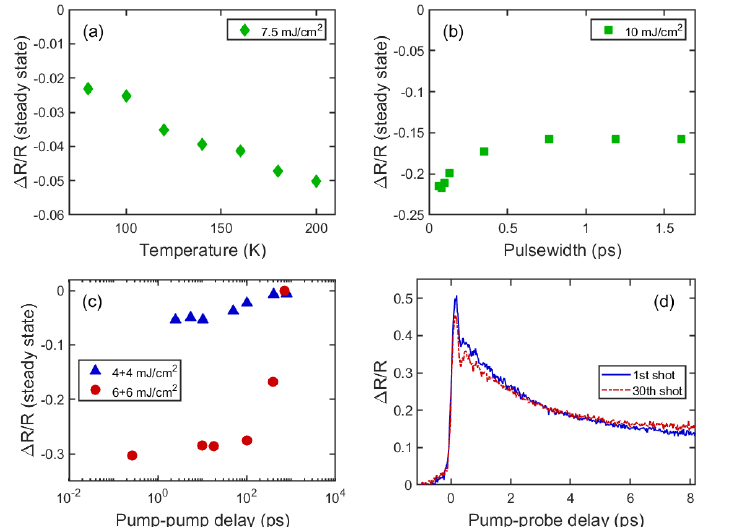
Fig. 1. The change in steady-state reflectivity under single-pump excitation with (a) different initial temperatures and (b) different pump pulse widths and (c) under double-pump excitation with various pump-pump delays. (d) The single-shot transient reflectivity trace under single-pump excitation with fluence of 7.5 mJ/cm 2 . (b), (c), and (d) were measured at 80